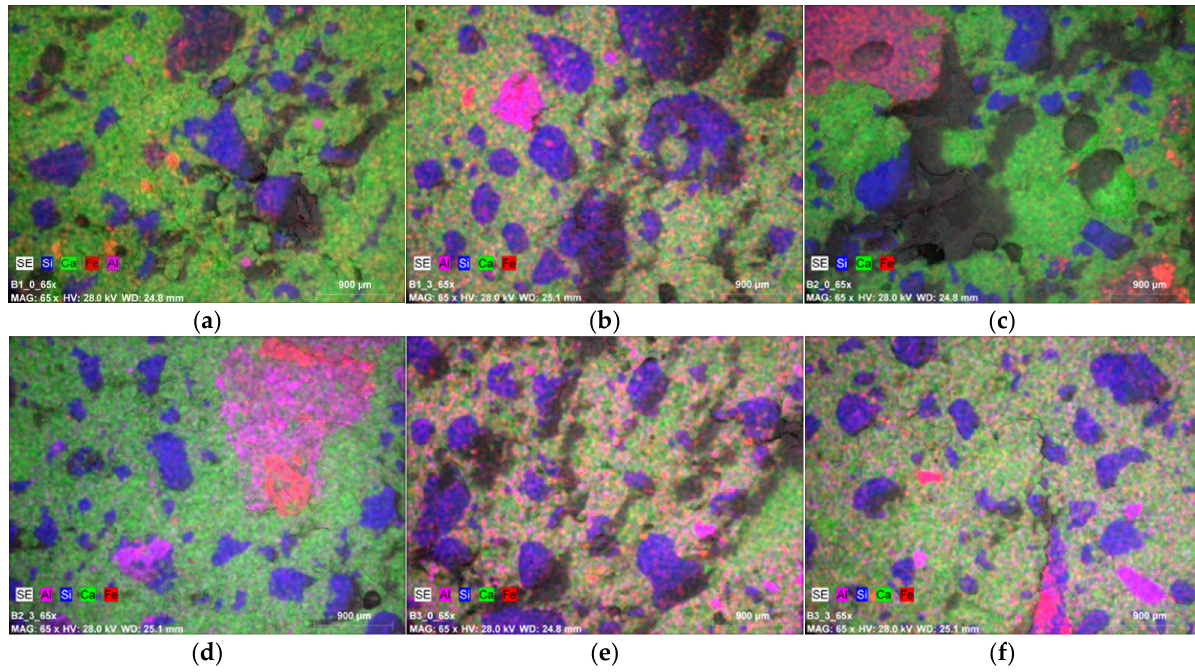
Figure 9. Maps of distribution of dominant elements in the studied area: ( a ) B1 ‐ 0; ( b ) B1 ‐ 3; ( c ) B2 ‐ 0; ( d ) B2 ‐ 3; ( e ) B3 ‐ 0; ( f ) B3 ‐ 3.